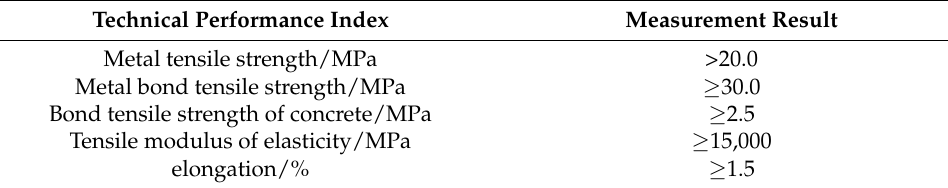
Table 5. Properties of JGN-C building structure adhesive.